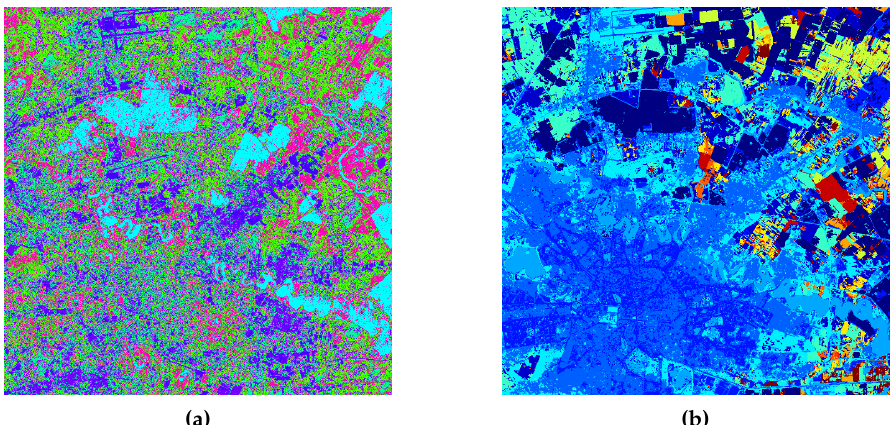
Figure 15. Analysis of long Landsat SITS: ( a ) DTW-based K-means clustering [7], ( b ) LDA-based clustering